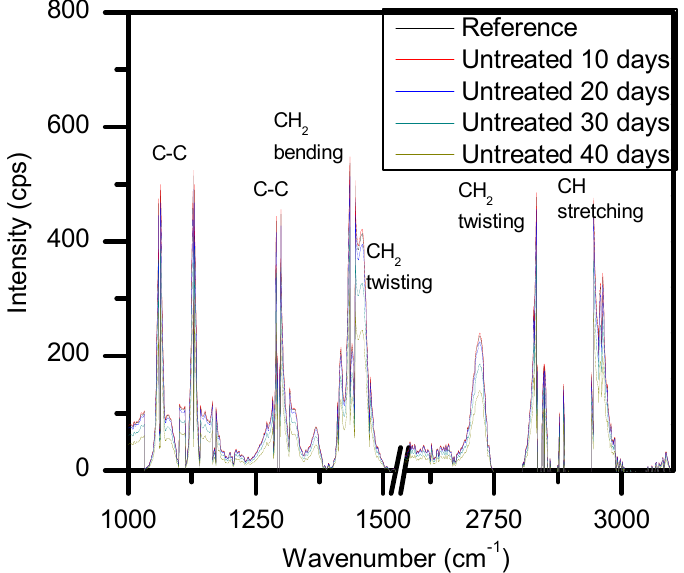
Figure 11. Representation of the typical Raman spectra of LDPE and the affiliated carbon bonds to help determine degradation of the samples.